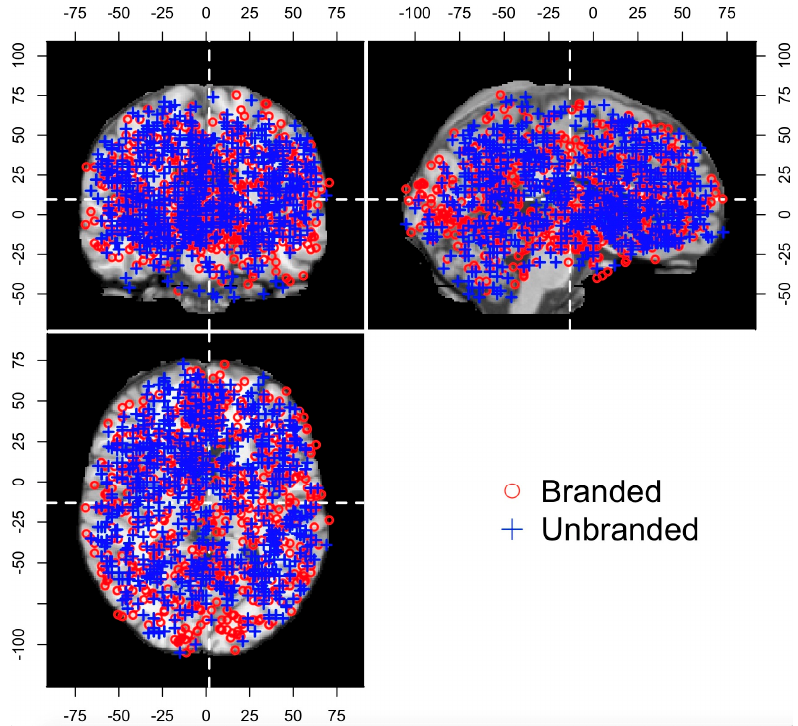
Figure 2. All foci plotted on the Colin27 template. Top left = coronal view; Top right = sagittal view; Lower right = axial view.